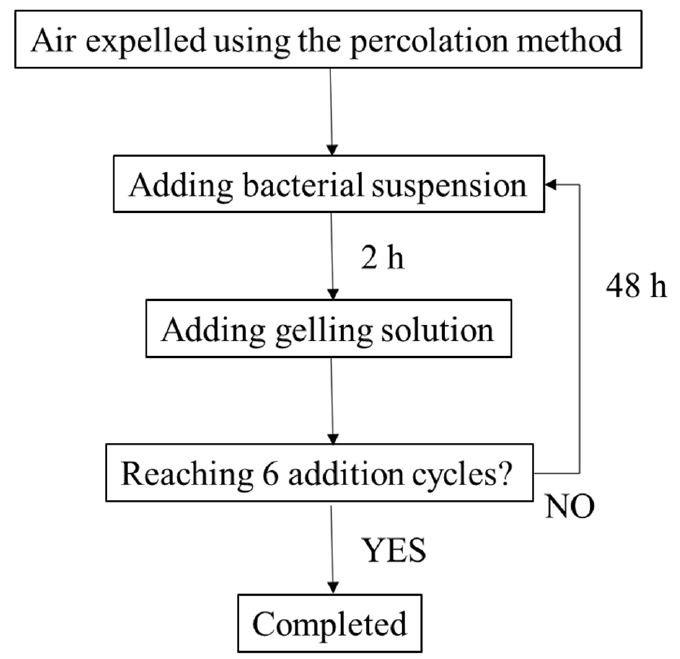
Figure 2. Flow chart of the treatment procedures.